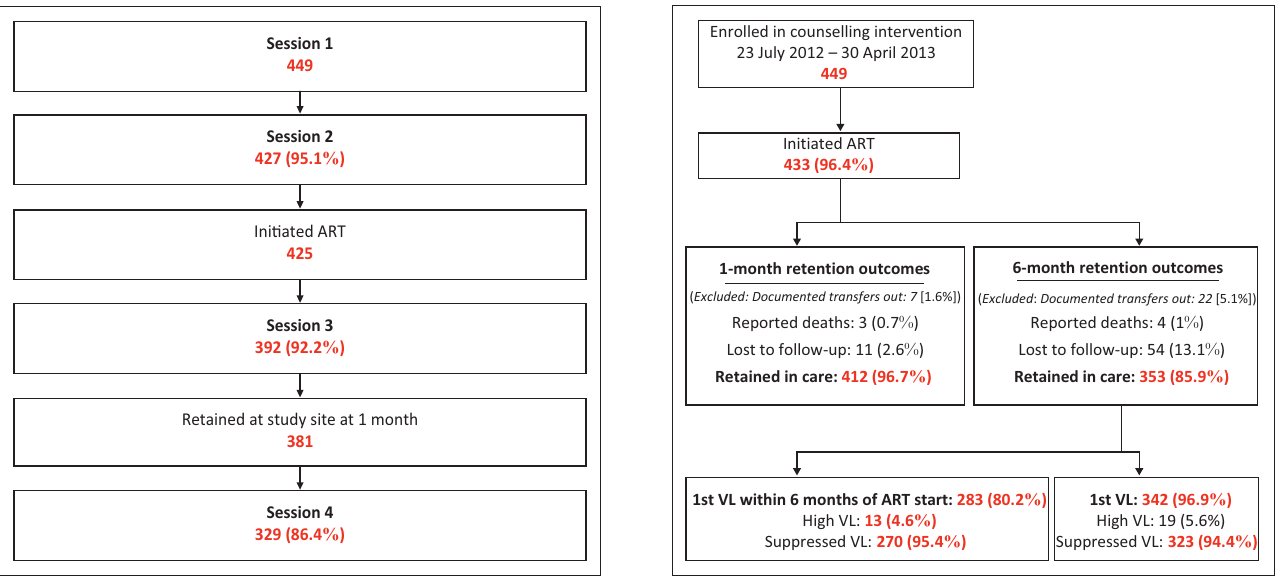
ART, antiretroviral treatment. FIGURE 2: Counselling session completion. FIGURE 3: Retention and viral load outcomes. TABLE 2: Time from enrolment (session 1) to antiretroviral treatment start and first viral load. Category Subcategory Enrolment (session 1) to antiretroviral treatment start